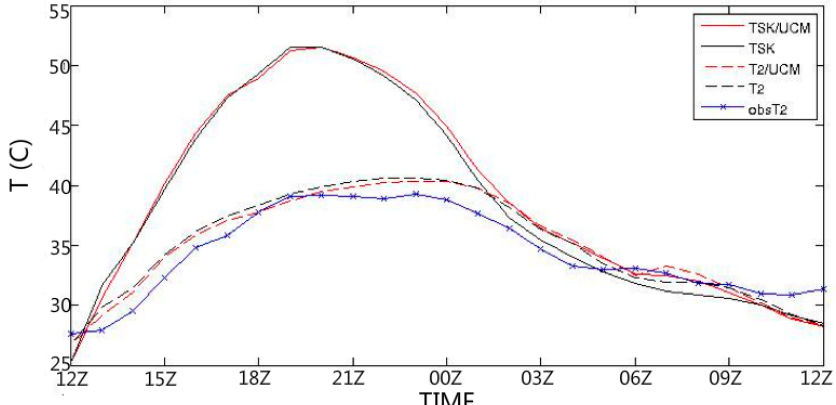
Figure 14. Comparison of WRF-simulated skin temperature (TSK in legend) and 2 m air temperature (e.g., T 2 ) with the ground-observed air temperature (e.g., obs T 2 ). The red solid line represents the model-simulated skin temperature with SLUCM turned on (e.g., the sensitive run); the black solid line represents the model-simulated skin temperature without SLUCM turned on (e.g., the control run); the red dashed line shows the model-simulated 2 m air temperature with SLUCM; the black dashed line shows the model-simulated 2 m air temperature without SLUCM; the blue line represents the ground-observed air-temperature from PNNL HOBO Station 9. Temperature is in °C. Although the diurnal range and phase were well simulated, an overestimation on 2 m T air occurred in the day for both the sensitive and the control runs. By calculating the urban fractions for both land cover maps, WRF-simulated land use for urban regions in OKC is obtained with a value of only 2%, which is much smaller than its actual condition with an urban fraction of 20%. Such a significant difference in urban fraction may directly lead to surface temperature deficiencies in the WRF simulation.